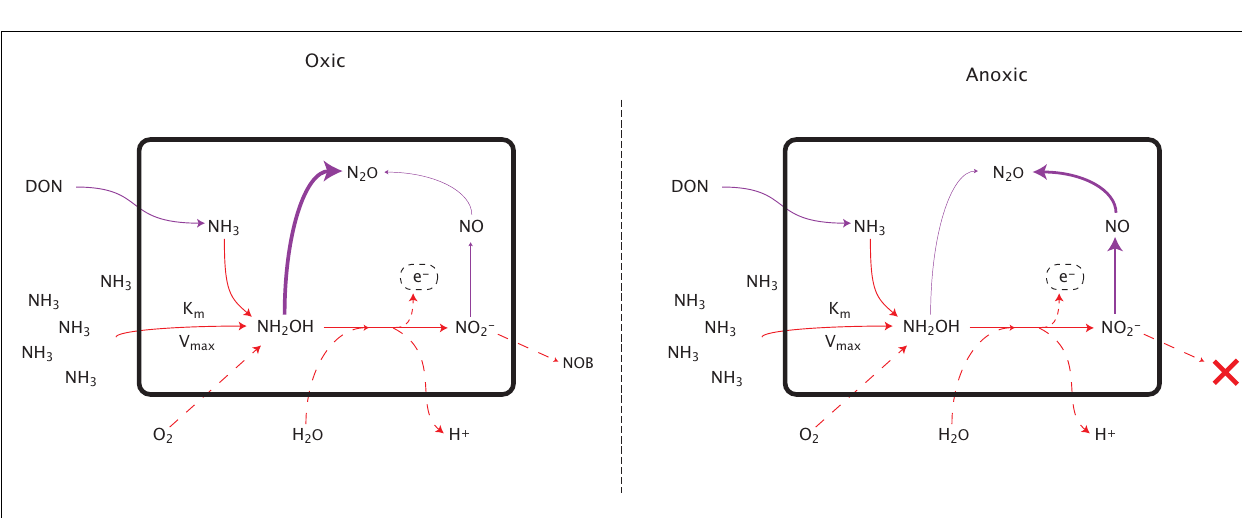
FIGUREA2 | Pathways of nitrous oxide production during nitrification. See text for detailed